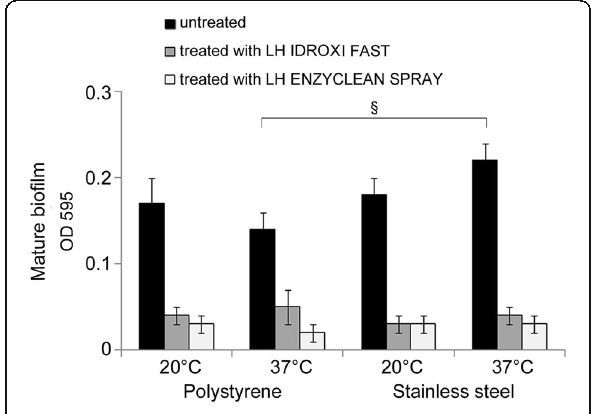
Fig. 1 The ability of E. hirae ATCC 10541 to form biofilm on polystyrene and stainless steel, at 20 and 37 °C and in vitro antibiofilm action of disinfectants LH IDROXI FAST and LH ENZYCLEAN SPRAY tested at the same conditions. The untreated and treated biofilms were analyzed for the biomass production, after 48 h of incubation, through Cristal Violet staining method. The results were expressed as average of OD595 values of three experiments (mean value ± SD). Symbol represents result statistically significant ( p <0.05). In particular, § represents the statistically significant difference in the values observed between polystyrene and stainless steel at 37